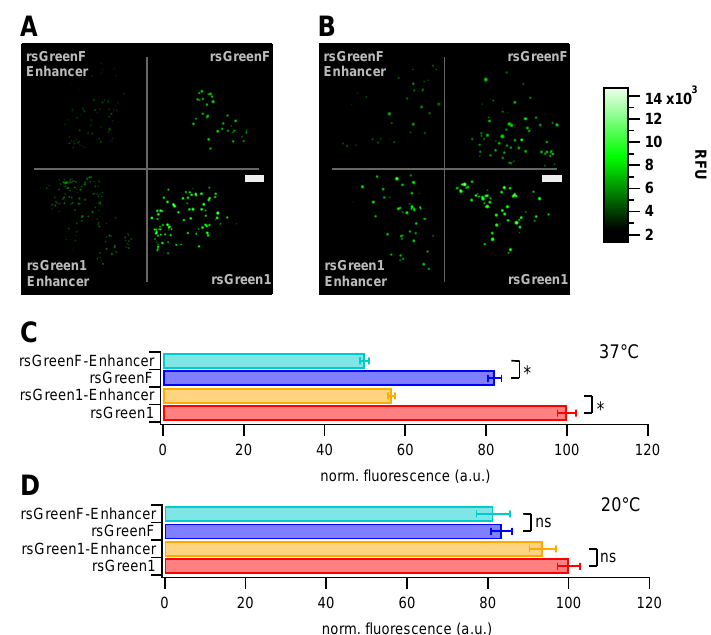
Figure 2. Effect of Enhancer nanobody fusion on the brightness of E. coli colonies expressing the different labels. ( A , B ) Fluorescence images of E. coli colonies expressing indicated labels, grown at 37 ◦ C ( A ); and 20 ◦ C ( B ) (RFU = relative fluorescence units, scale bar (white rectangles) = 1 cm). ( C , D ) Average colony fluorescence scaled to 100 for rsGreen1 for 37 ◦ C ( C ); and 20 ◦ C ( D ) plates. Error bars represent standard error on the mean. *: significant differences ( p ≤ 0.01). ns: not significant.